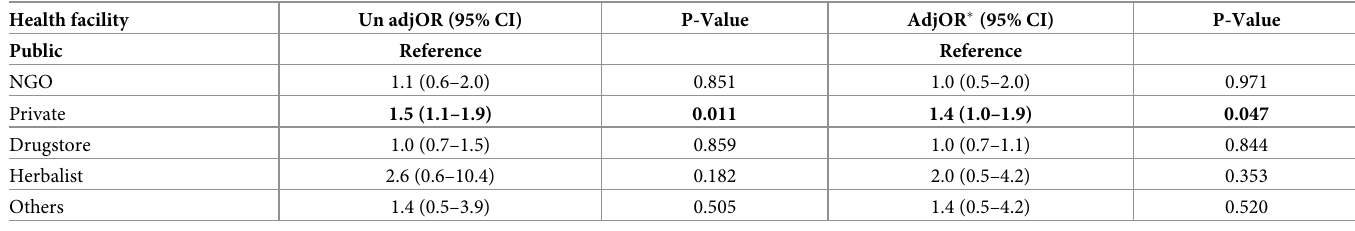
Table 4. Odds of being GeneXpert positive based on health facility initially